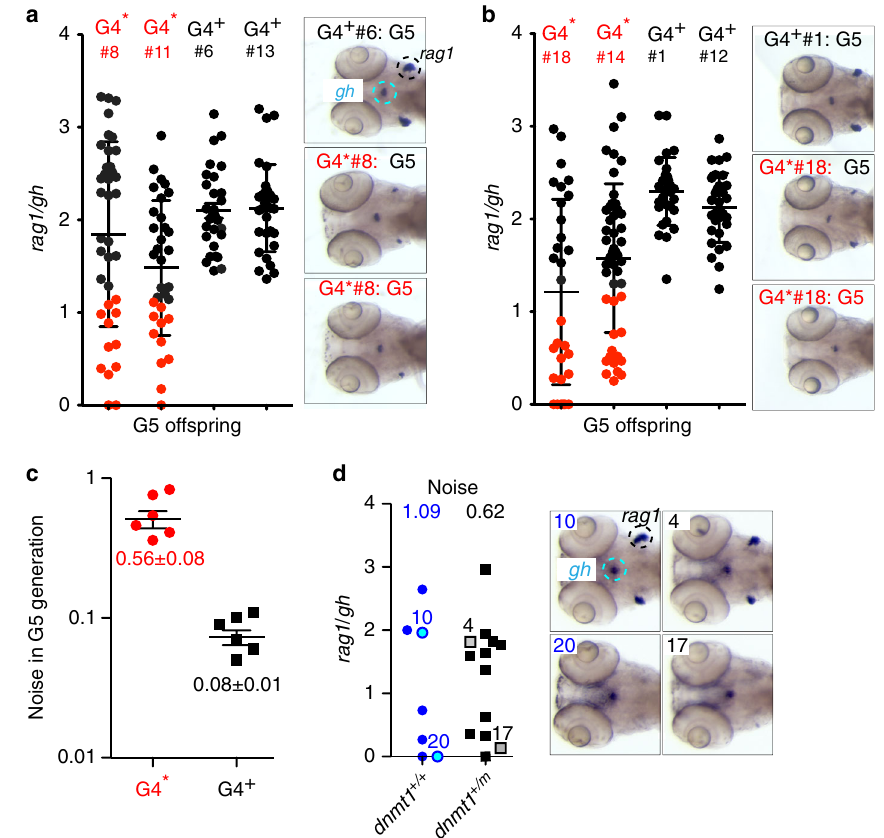
Fig. 5 Variable levels of larval T cell development in the G5 generation. a Extent of T cell development (expressed as rag1/gh ratio) in the G5 generation arising from dnmt1 + / + male G4 fi sh (c.f., a ). Red dots represent values of thymopoietic index of animals in G5 clutches arising from a G4* parent whose rag/gh ratios lie outside 2 standard deviations of values observed in G5 clutches arising from G4 + parents. Representative RNA in situ results are shown for G5 fi sh. b Extent of T cell development in the G5 generation arising from dnmt1 + / + female G4 fi sh. c Noise (calculated as variance/mean) values of rag1/gh data in G5 clutches arising from G4* and G4 + parents (mean ± s.e.m.). d Extent of T cell development (expressed as rag1/gh ratio) in the G5 generation arising from dnmt1 + /m male G4* fi sh; the mean noise values are indicated at the top (left panel). Representative RNA in situ patterns on which the calculation of rag1/gh ratios was performed are shown on the right for the animals identi fi ed by numbers in the left panel. In ( a – d ), each data point represents one animal. Source data are provided as Source Data fi